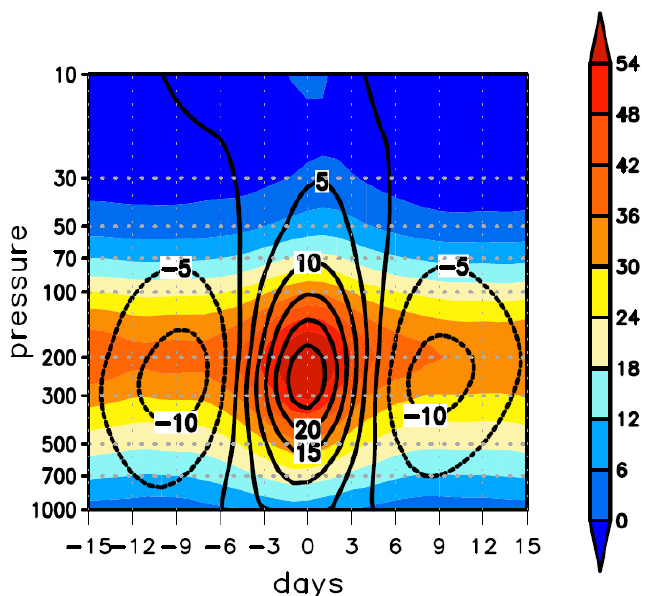
Figure 4. The time-altitude profile of the zonal wind (color shaded) and the intraseasonal zonal wind (contoured) in the jet exit region (unit: m/s).